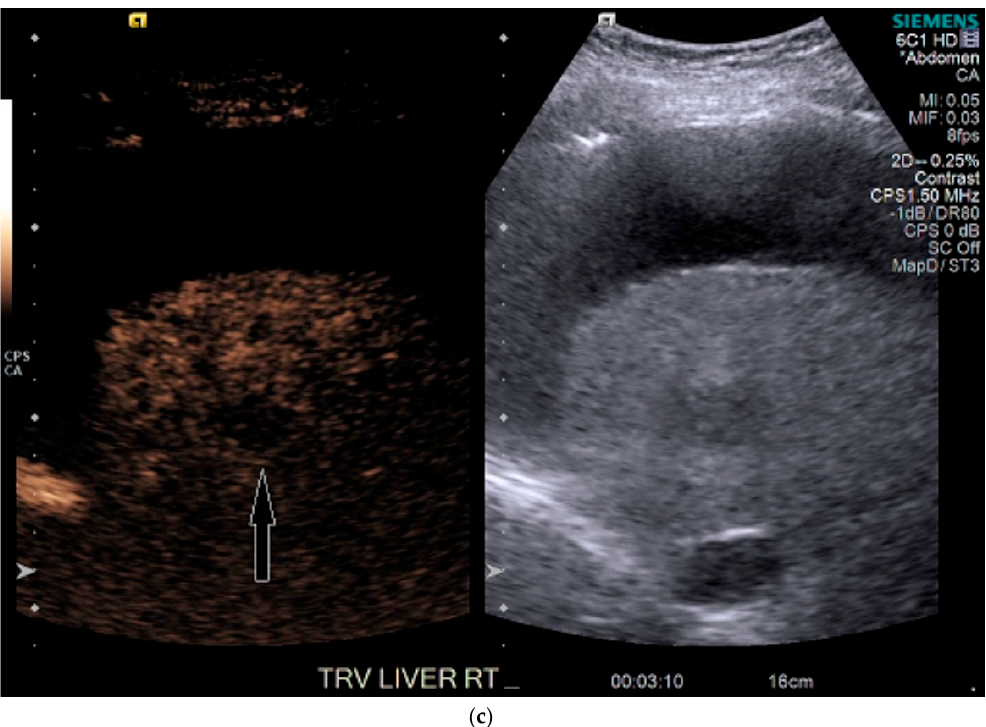
Figure 5. Patient 3 ultrasound images, ascites is present with lesion denoted by white arrow: ( a ) grayscale images showing the hypoechoic lesion. Post contrast administration ultrasound in arterial phase shows subtle enhancement compared with liver parenchyma at the same level ( b ) and delayed phase mild washout ( c ) of the lesion, LI-RADS 5.